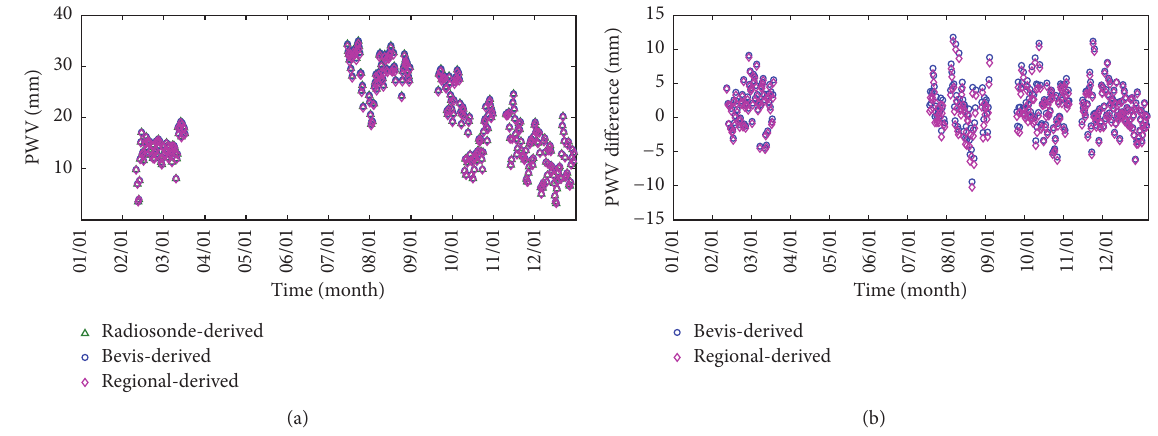
Figure 8: (a) Comparison between PWVs (twice daily) resulting from the BTM and seasonal two-factor RTMs-derived 𝑇 𝑚 against the truth during 2015. (b) Accuracy of the two sets of PWVs.